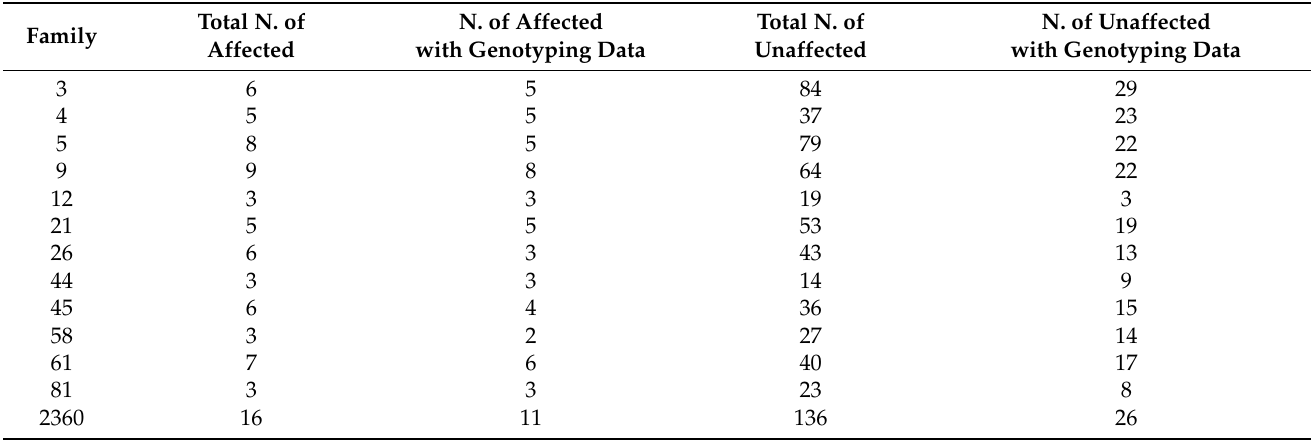
Table 1. Description of the family data available for the HH analysis. For each family, the total numbers of affected and unaffected subjects are reported together with the availability of Immunochip genetic data. Total N. Family